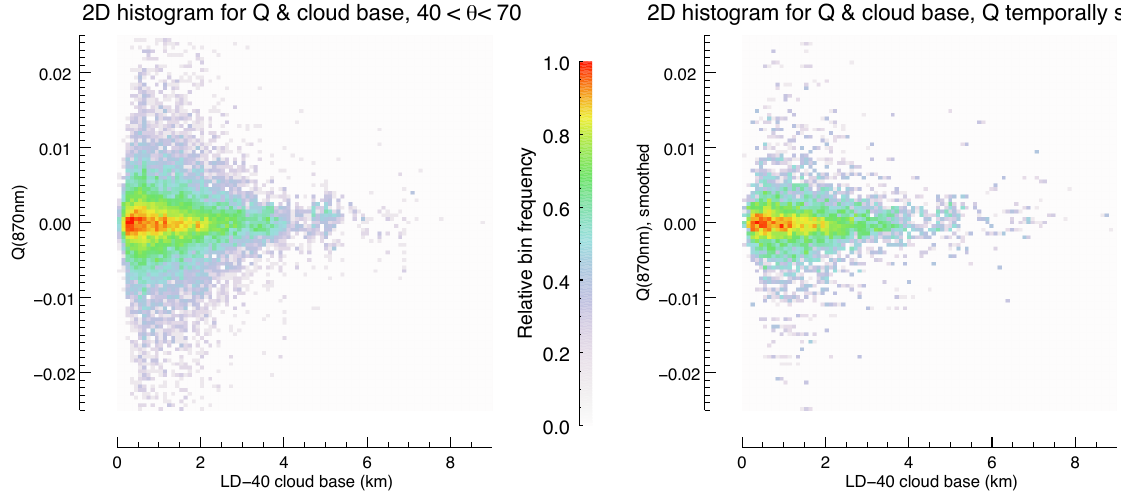
Figure 12. Two-dimensional histograms of the single-channel AERONET Q compared to cloud base height determined by the LD-40 ceilometer at the CESAR site. Original AERONET data are shown on the left, while the values at the right represent temporally smoothed values. To clarify display, Q s with an absolute value less than 0.0001 were removed. For the original data, 50% were larger than this threshold, while 46% were less. For the smoothed data, 48% were larger than this threshold, while 45% were less. Data were gathered between 9 June 2010 and 28 February